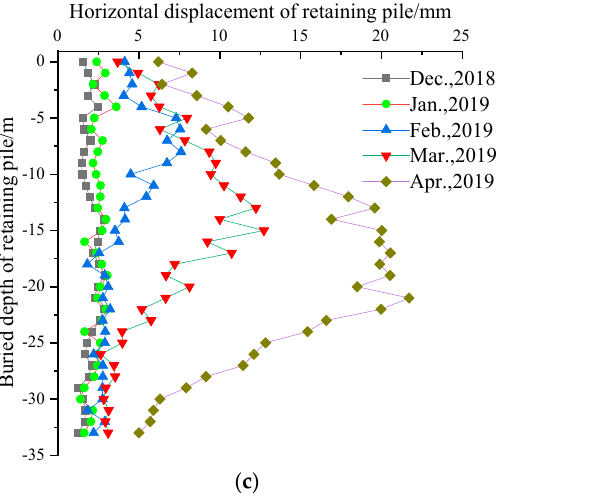
Figure 7. Time − history curve of the deep horizontal displacement of the retaining pile. ( a ) Measuring point ZQT-4; ( b ) measuring point ZQT-9; ( c ) measuring point ZQT-15; ( d ) measuring point ZQT-21.